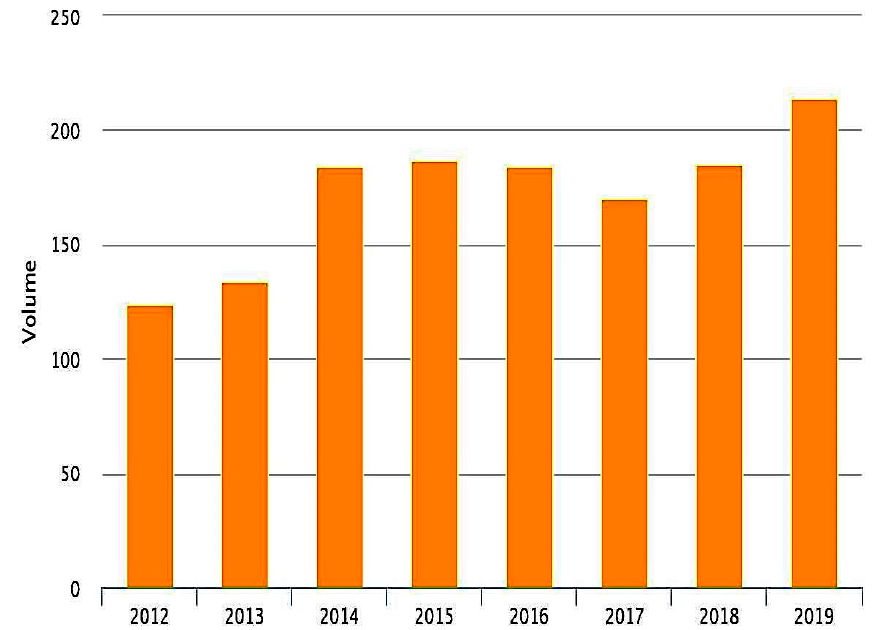
Figure 2. Number of acute ischemic stroke admitted in the hub hospital of San Giovanni Battista Hospital in Foligno from 2012 to 2019.